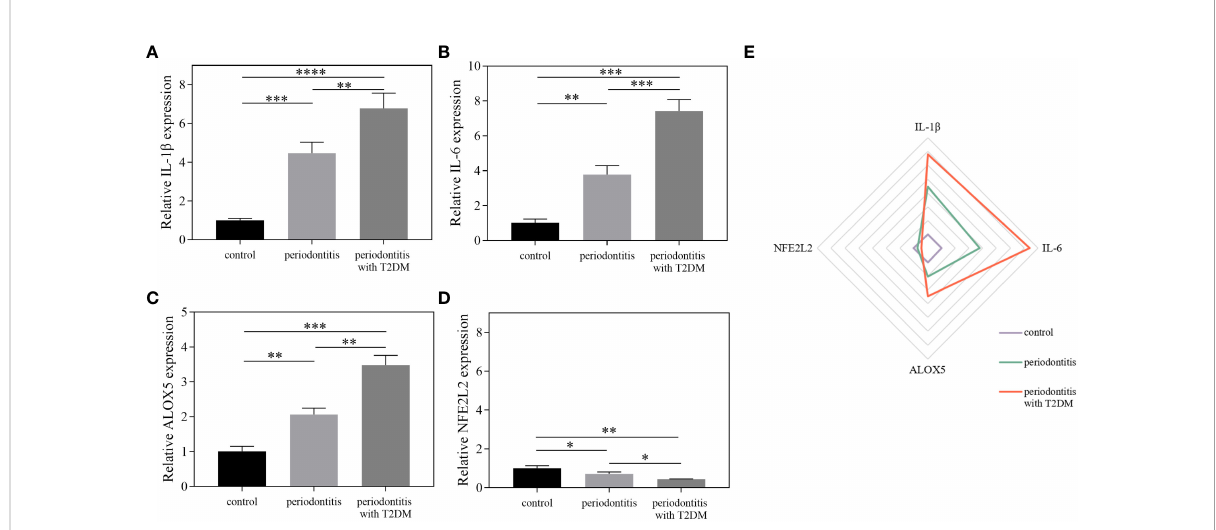
FIGURE 7 The results of qRT-PCR. (A – D) The relative expression levels of IL-1 b , IL-6, ALOX5 and NFE2L2 between different groups using qRT-PCR. (E) Differentially expressed factors were shown as a Radar Chart. The qRT-PCR data were analysed by ANOVA. A p-value < 0.05 was